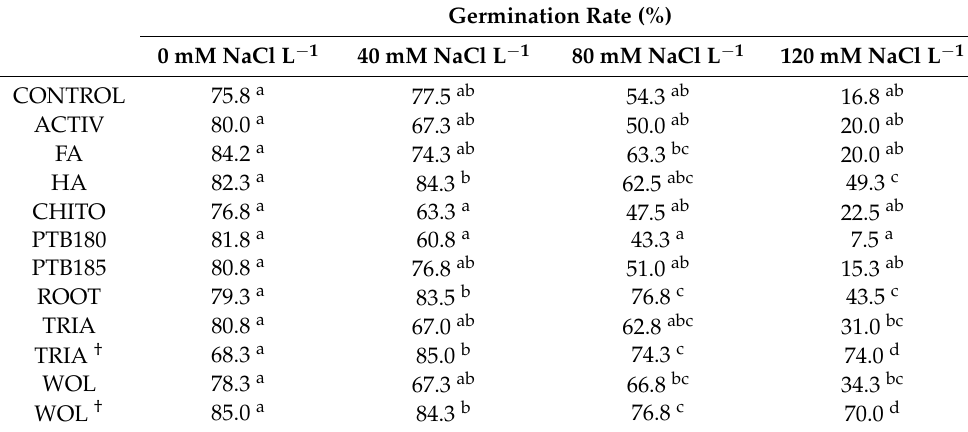
Within the same column, means ( n = 4) followed by a same letter are not significantly different, according to Fisher’s protected LSD test ( p ≤ 0.05). Seeds were treated with Ascophyllum nodosum extract (ACTIV), fulvic acid (FA), humic acid (HA), chitosan (CHITO), Bacillus pumilus PTB180 (PTB180), Bacillus subtilis PTB185 (PTB185), Trichoderma harzianum T-22 (ROOT), triacontanol (TRIA), wollastonite (WOL), or water (CONTROL). † Treatment applied by substrate